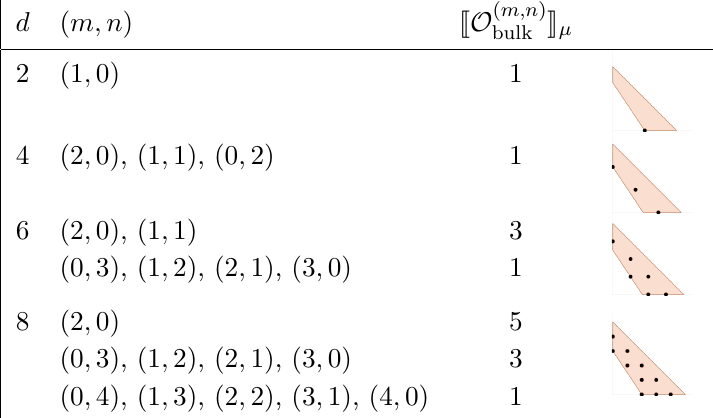
Table 1 . Divergent bulk operators in different